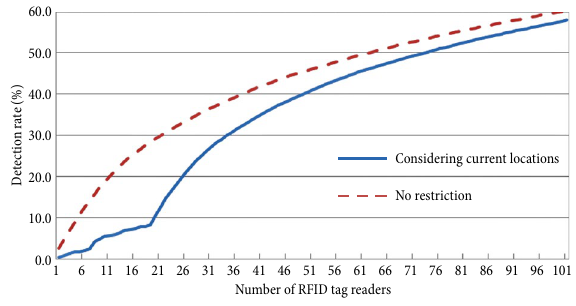
Number of RFID tag Fig. 6. Number of RFID readers and detection rates